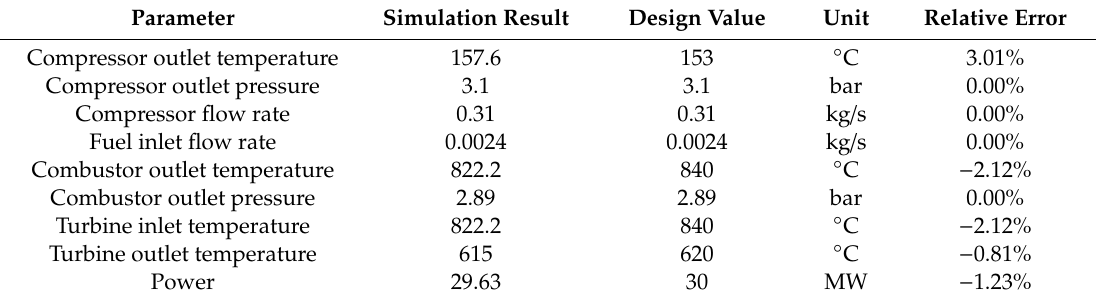
Table 2. Comparison of the MGT parameters between the design value [24] and the simulation